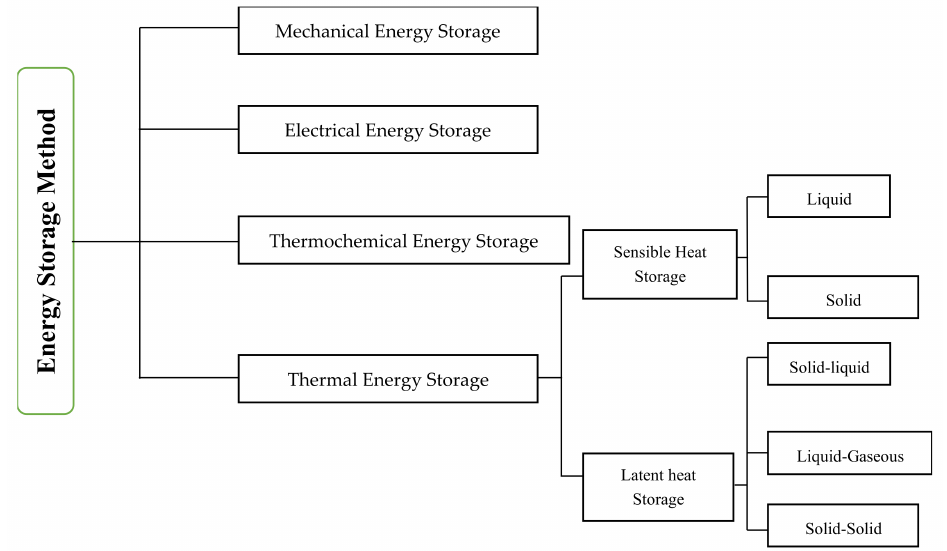
Figure 3. Different type of energy storage method